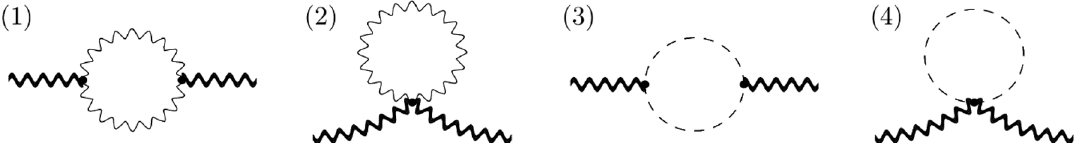
Figure 1 . Supergraphs which allow to calculate the divergent part of the one-loop e(cid:11)ective action for the model (2.13). The dashed lines stand for all ghost super(cid:12)elds present in the theory.